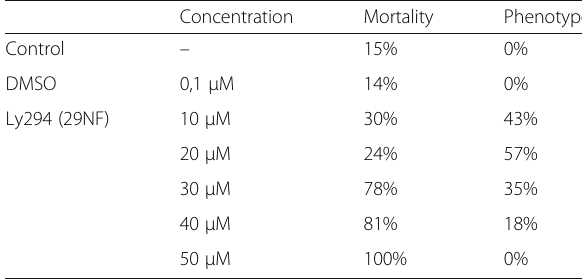
Phenotypes were determined 6 days after incubation based on mandibular arch abnormalities including the appearance of ectopic cartilages. n =90 for controls and each concentration of